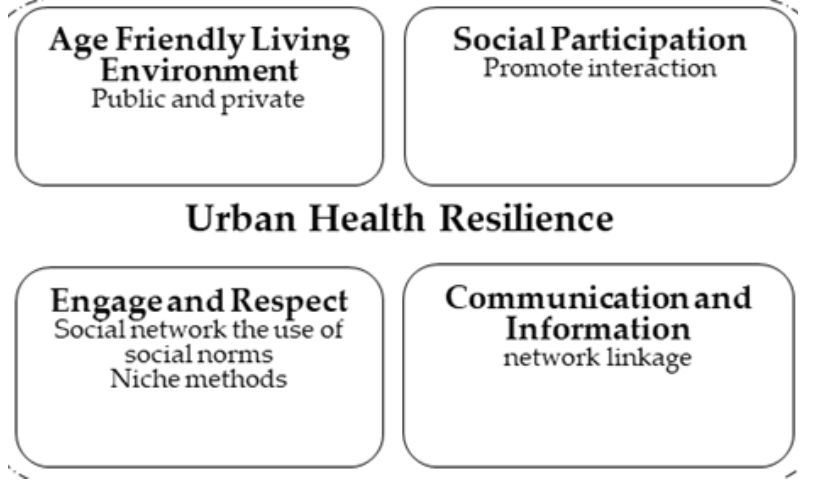
Figure 8. Dimensional principles affecting the urban health resilience and aging-friendly